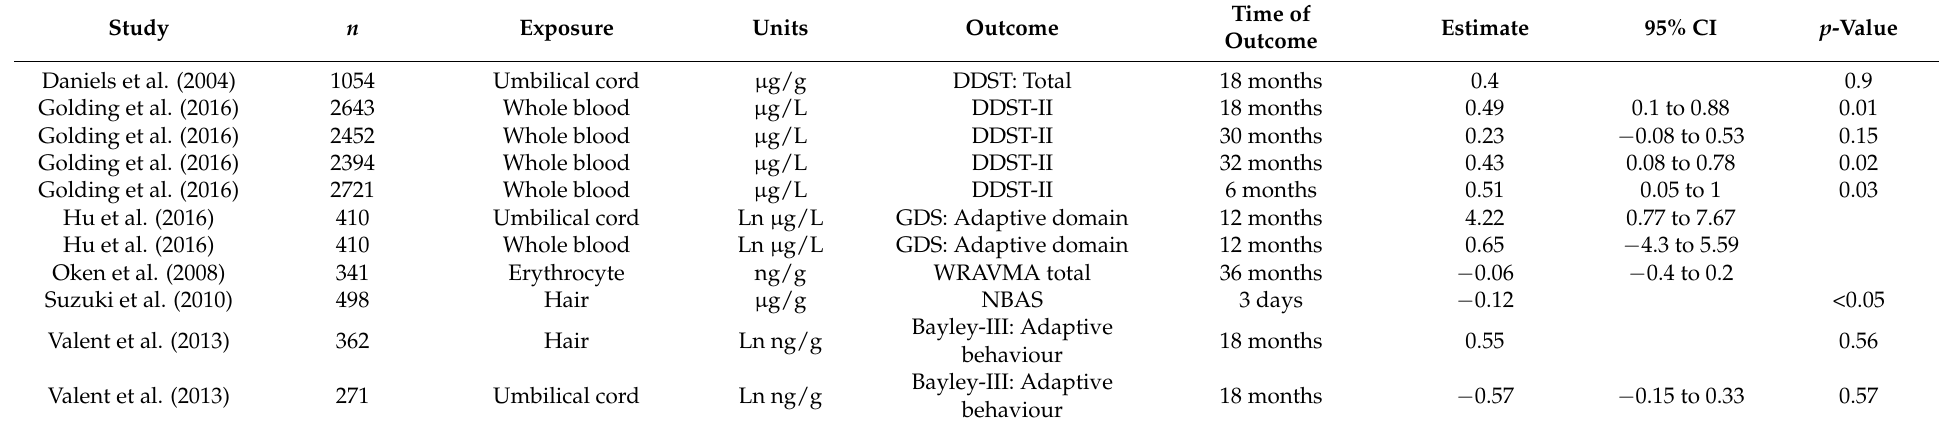
Table 9. Results from studies identified as high quality which measured general or composite measures of neurodevelopmental functioning ( n =